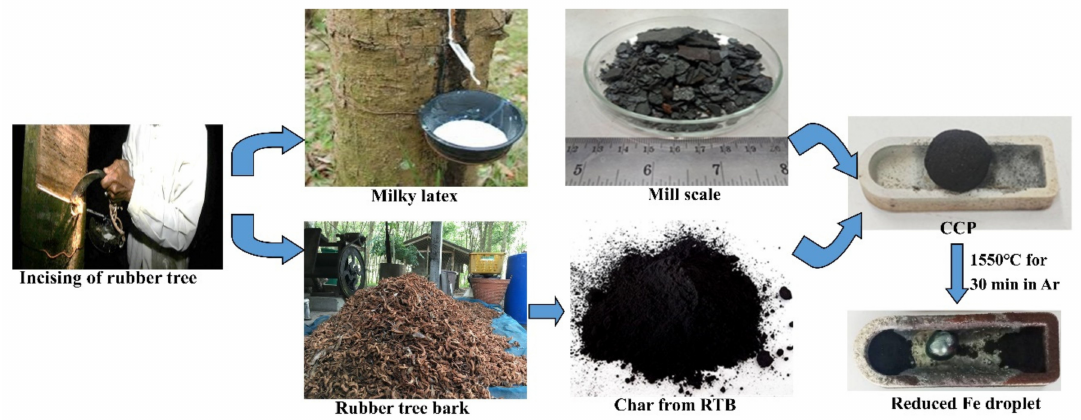
Figure 2. Research overview for the present